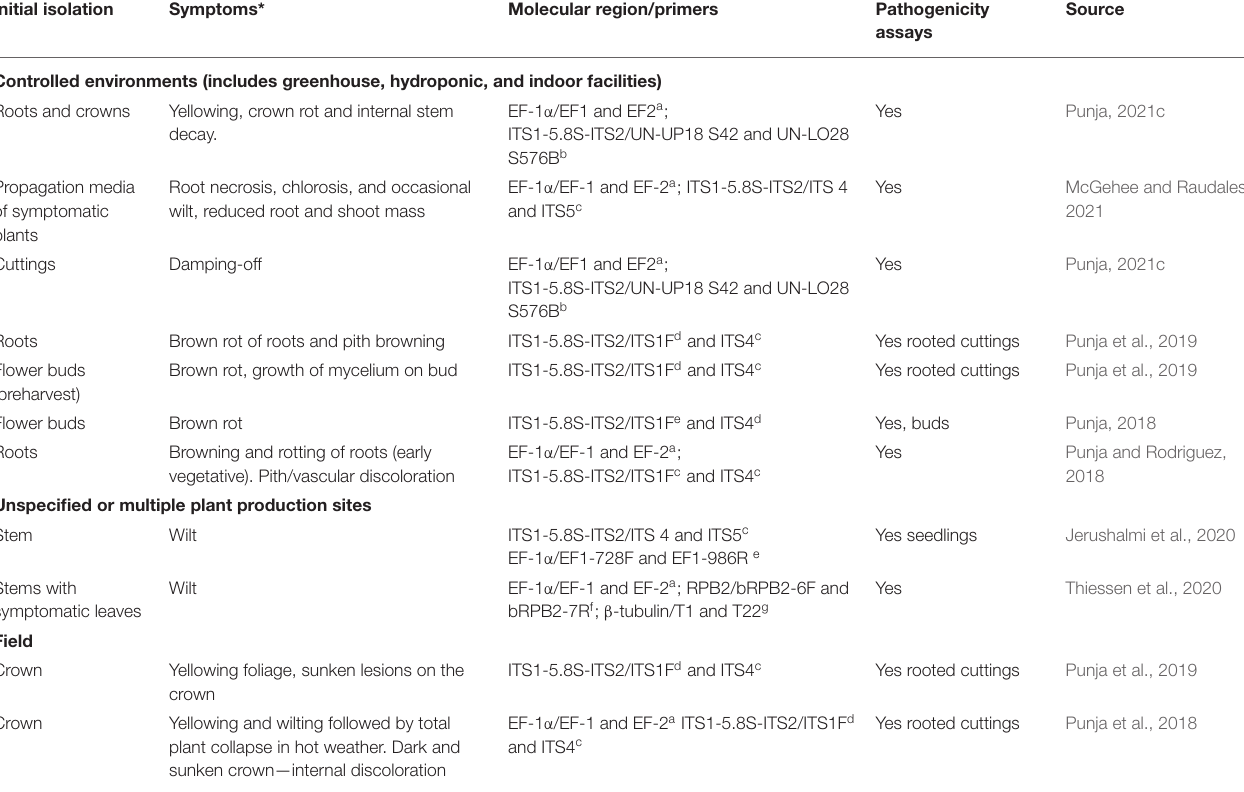
TABLE 1 | Disease reported in Cannabis sativa caused by Fusarium oxysporum